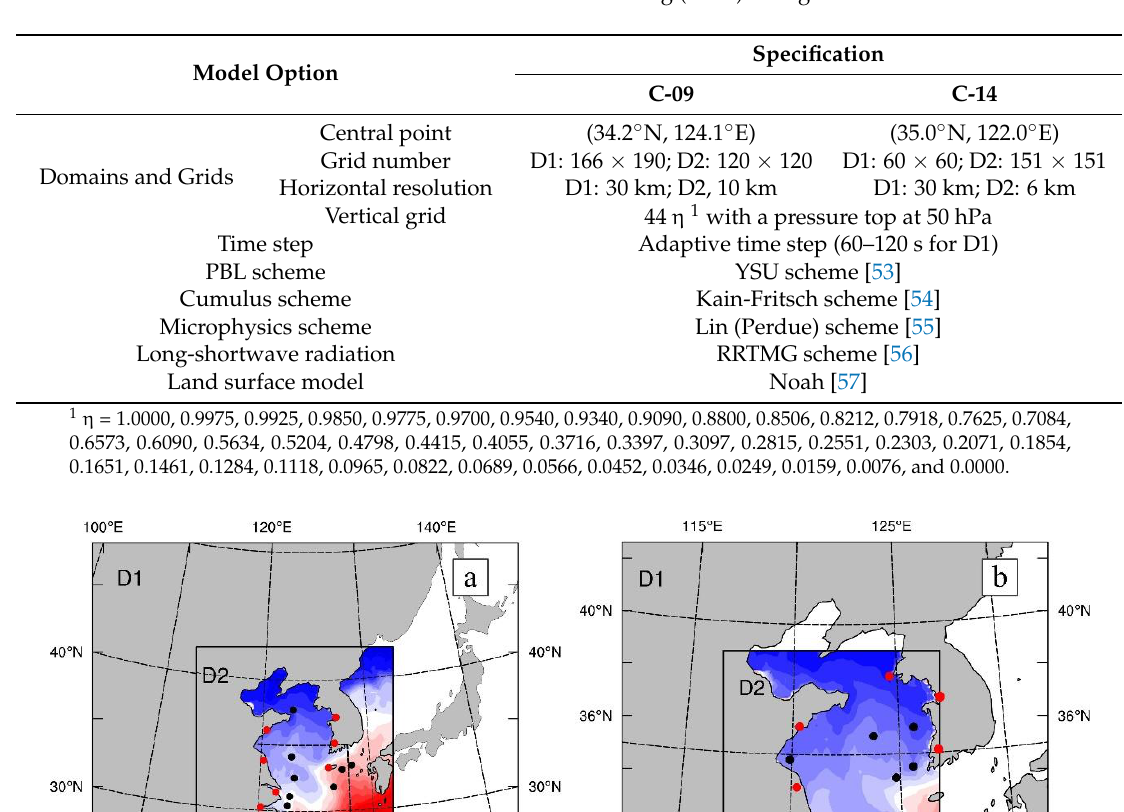
Table 1. Weather Research and Forecasting (WRF) configuration.